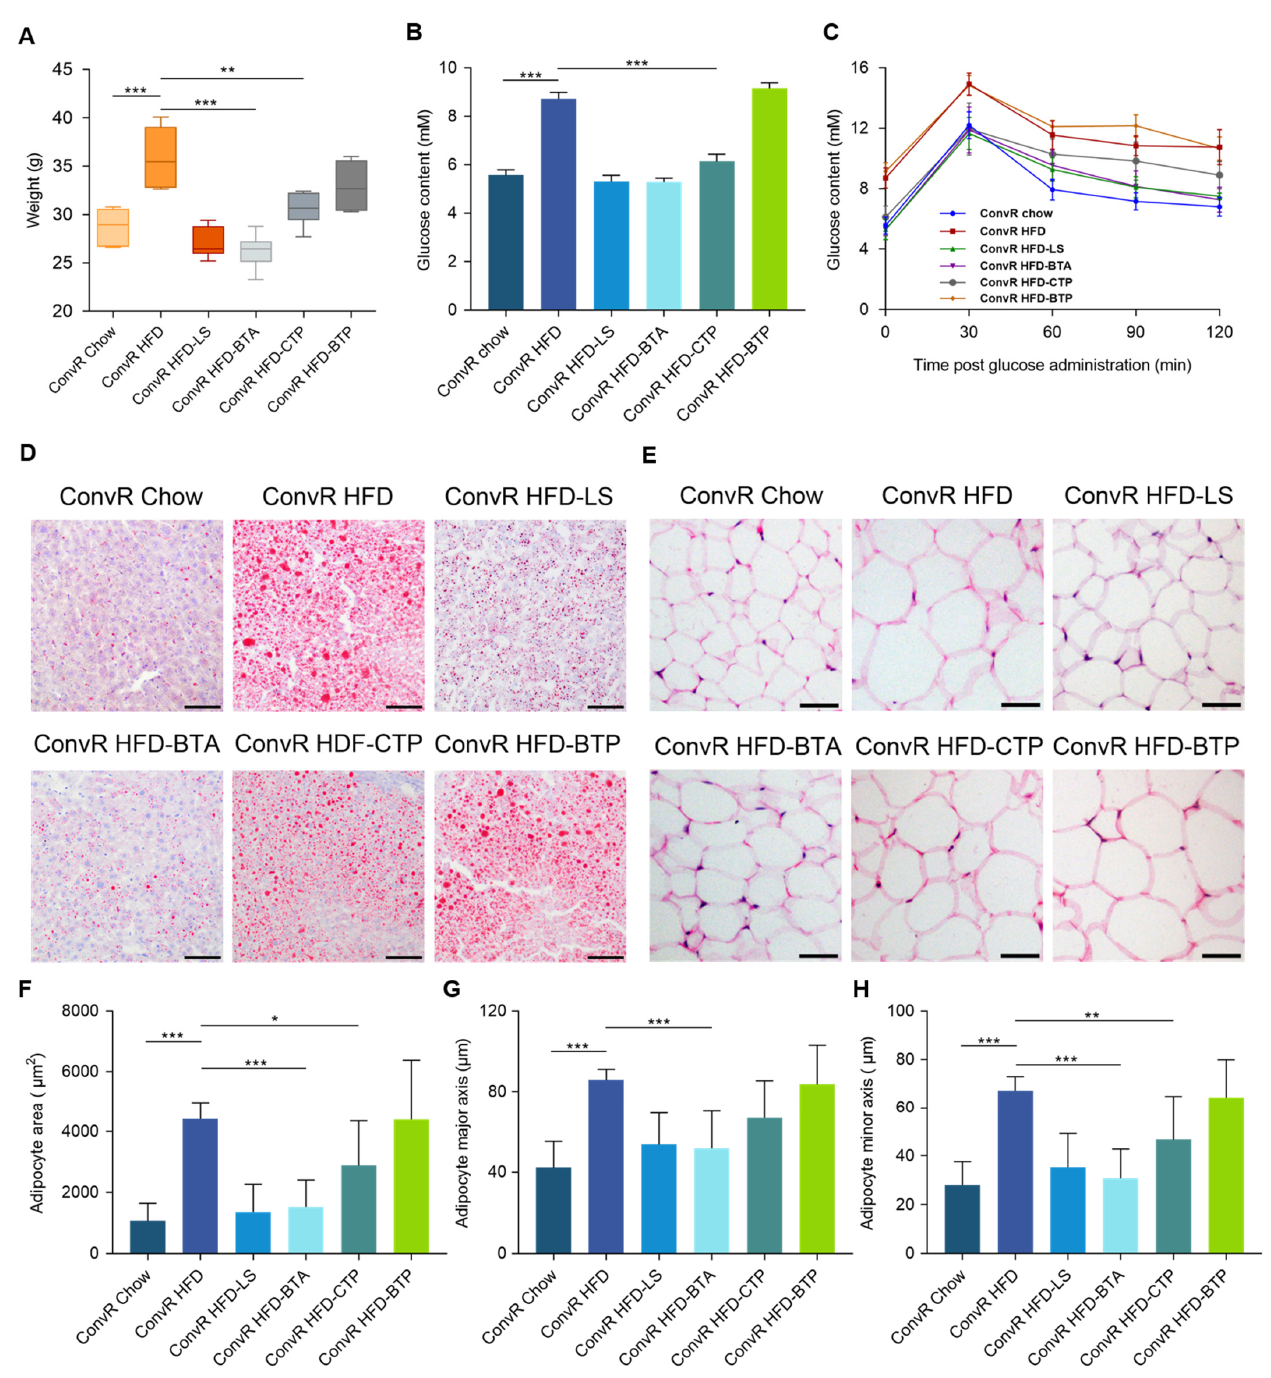
Figure 2. Body weight and lipid lowering effects of BTA, CTP, and BTP. Weights ( A ), liver lipid content ( D ), and epididymal adipocyte size ( E – H ) of Chow- and HFD-fed ConvR mice treated with water, LS, BTA, CTP, or BTP at the time of sacrifice. In ( D ), liver lipid content was assessed using oil red O staining. Scale bar, 100 μ m. In ( E ), adipocyte size was estimated using the Image J software. Scale bar, 50 μ m. Fasting glucose ( B ) and the oral glucose tolerance ( C ) of mice with different trentments. Mice fasted overnight were given glucose by oral gavage (2 mg/kg BW). Blood glucose was determined at 0, 15, 30, 60, and 120 min post glucose administration. Differences of data in mice ( A – C , F – H ) were analyzed using one-way ANOVA analysis *** p < 0.001, ** p < 0.01, * p < 0.05; error bars represent SEM; n = 6 mice per condition.